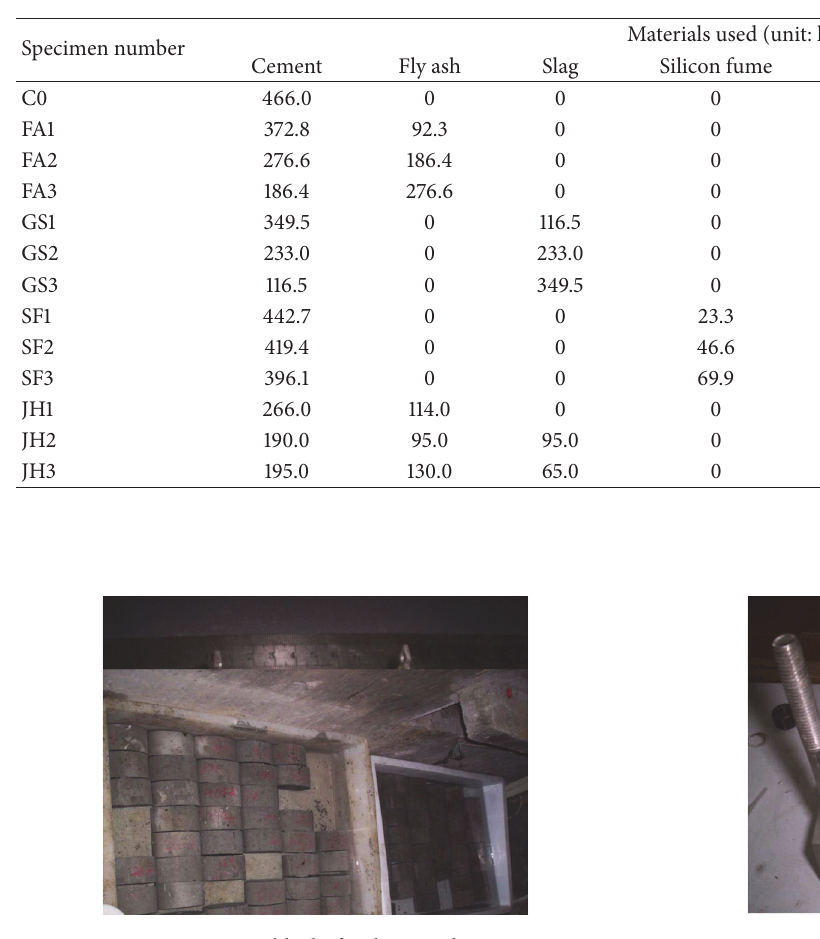
Figure 9: Electrode mounting.